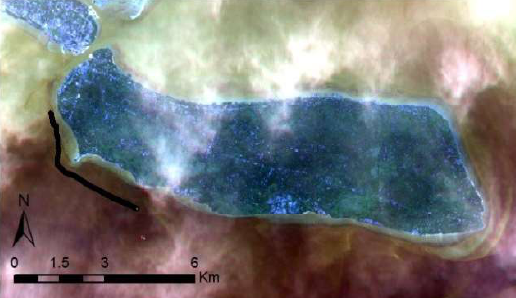
Figure 2. All Points of Measured Sea Surface Temperature